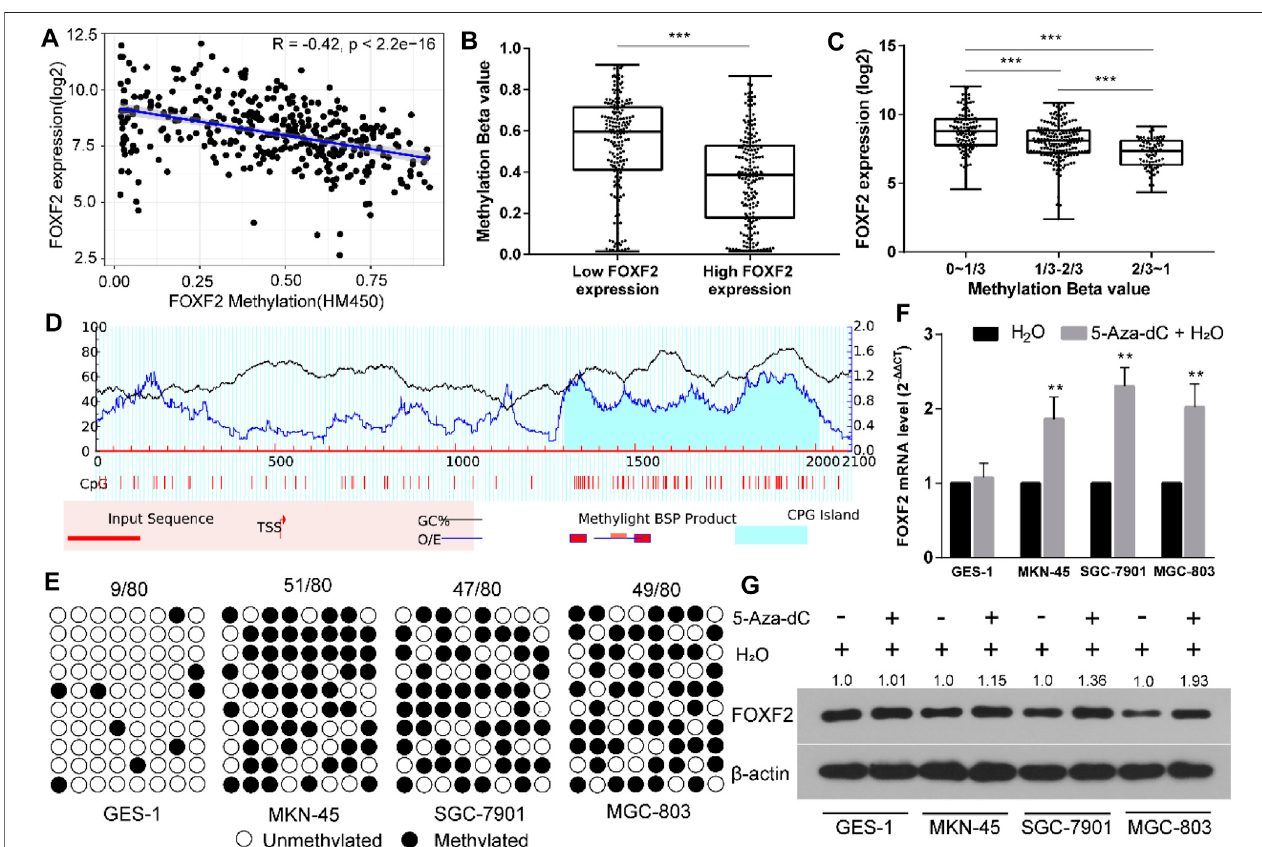
FIGURE 3 | FOXF2 was downregulated through aberrant DNA methylation in the promoter region. (A) FOXF2 expression was negatively correlated with FOXF2 methylationlevel(PearsonR (cid:1) − 0.42, p < 2.2e − 16 ). (B) Atotalof372 GCsamplesweredividedintoloworhighFOXF2expressiongroupaccordingtothemedianvalueof FOXF2expression.Theunpaired t -testsuggestedthattheFOXF2methylationlevelinthehighFOXF2expressiongroupwaslowerthanthatinthelowFOXF2expression group. (C) The 372 GC samples were divided into low (0 – 1/3), median (1/3 – 2/3), and high (2/3 – 1) methylation groups according to the tertile of the methylation level.TheresultsshowedthatFOXF2expression waslowestinthehighmethylationgroupandthehighestinthelowmethylationgroup. (D) ACpGislandwiththelength of 708 bp was found in the promoter region of FOXF2 by Methprimer 2.0 prediction. (E) The BSP assay suggested that the methylation level of the FOXF2 promoter region in GC cell lines (MKN-45, SGC-7901, and MGC-803) was higher than that in the normal control GES-1 cell line. (F and G) qRT-PCR and western blot assay showed that the mRNA and protein levels of FOXF2 were increased in GC cells following treatment with 5-Aza-Dc; however, no difference was found in GES-1 cells. * p < 0.05, ** p < 0.01, and *** p <